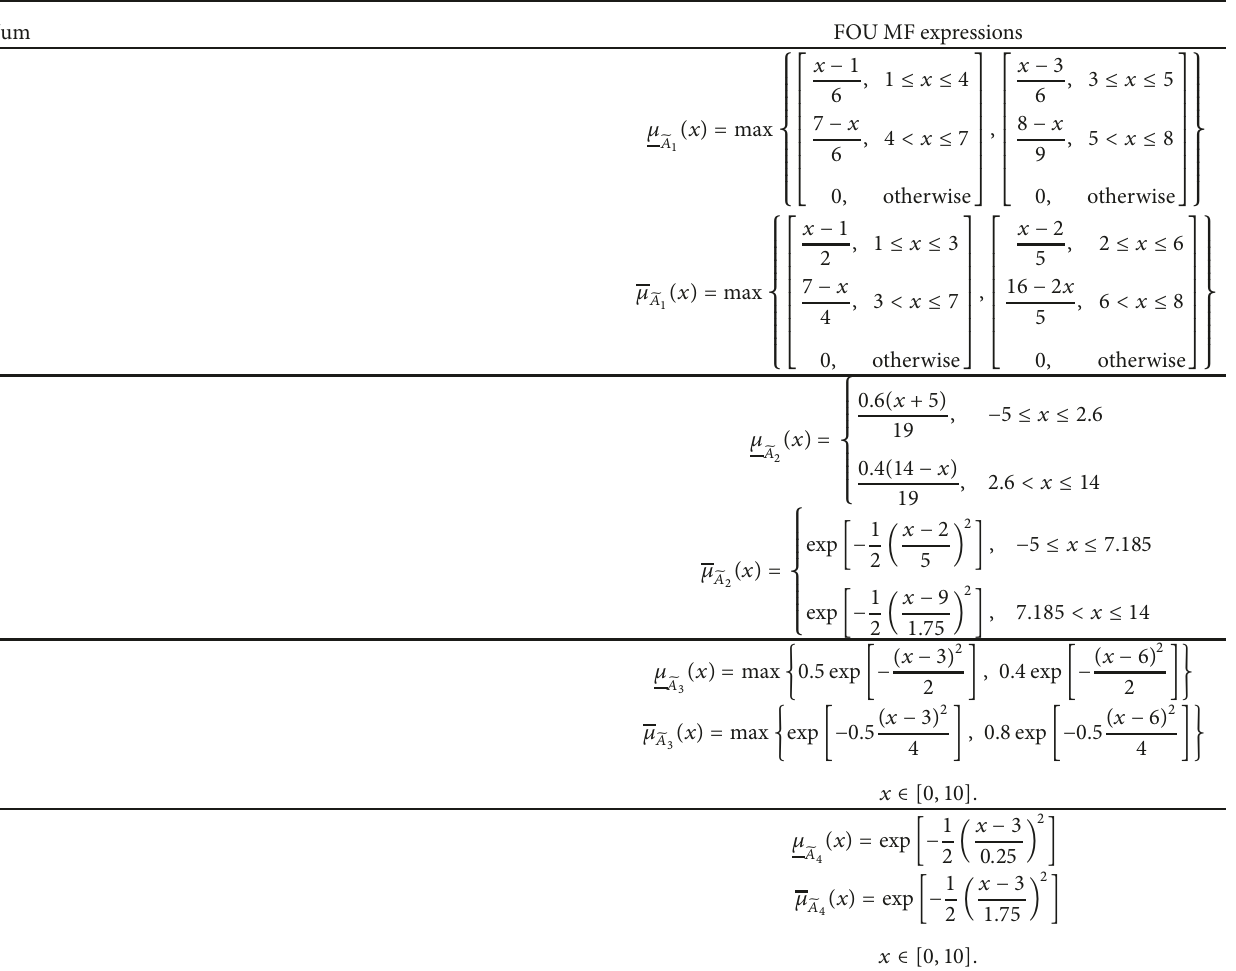
Table 1: FOU MF expressions of four examples.